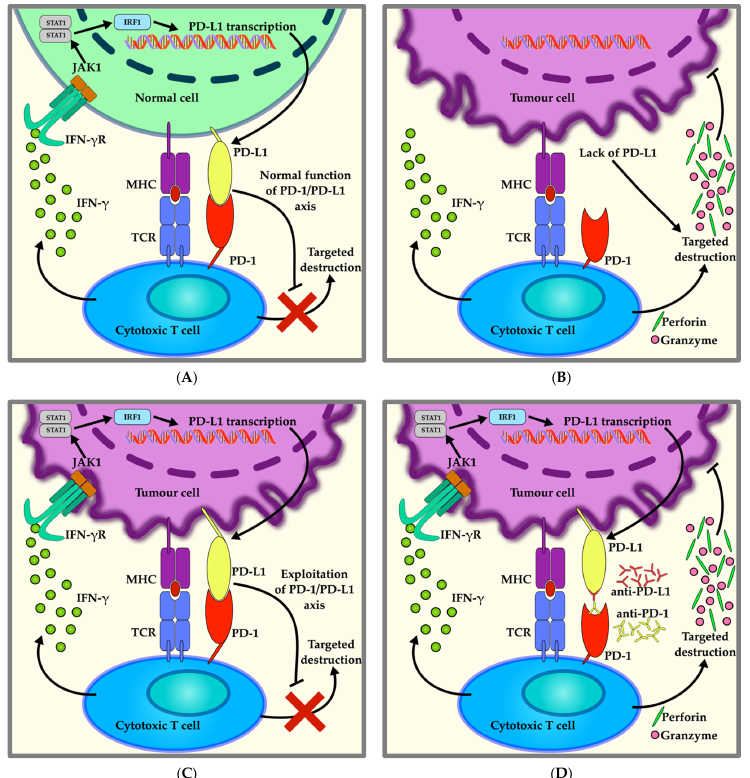
Figure 1. Immune targeting of cells by cytotoxic T cells: ( A ) Mechanism of immune tolerance of a native cell by the activa- tion of the PD-1/PD-L1 axis. A T cell is activated by an antigen presented on a major histocompatibility complex (MHC) molecule on the surface of the cell. This triggers the release of inflammatory cytokines, such as interferon gamma (IFN- γ ), that bind its receptor (IFN- γ R) on the cell membrane, upregulating the expression of PD-L1 . The interaction between PD- L1 and PD-1 on the T-cell surface works as a mechanism of cell recognition and promotes immune tolerance, preventing the destruction of the cell. ( B ) Mechanism of immune targeting of a tumour cell. Conversely, when the cytotoxic T cell recognizes the antigen presented on an MHC, but no PD-L1 is expressed, the release of IFN- γ and cytolytic mediators (perforin and granzymes) results in (tumour) cell elimination. ( C ) Mechanism of immune evasion of the tumour cell by exploiting PD-1/PD-L1 axis. The cytotoxic T-cell activation recognizes the tumour antigen presented on its MHC, but PD- L1 transcription is activated by IFN- γ . PD-L1 inhibits anti-tumour activity of the cytotoxic T cell. ( D ) Mechanism of PD- 1/PD-L1 blockade by anti-PD-1 or anti-PD-L1 immune checkpoint inhibitors (ICIs). The antibodies block the interaction between PD-1 and PD-L1, preventing inhibition of cytotoxic T-cell antitumor activity and triggering the release of perforin and granzymes for the elimination of the tumour cell and thereby surpassing the PD-1/PD-L1 blockade. 3. Immune Checkpoint Inhibitors and Immunotherapy In the later 20th century, blockage of the interaction between PD-L1 and PD-1 was proposed as a possible therapeutic path to combat tumour growth, and studies using monoclonal antibodies targeting immune checkpoints (such as PD-L1/PD-1) started to proliferate (Figure 1D). These antibodies are referred to as immune checkpoint inhibitors (ICIs). It was clear from the early studies with mice xenografts that treatment with ICIs produced recovery of effector T-cell functions and a decrease in tumour size [15,16]. In 2015, the Food and Drug Administration (FDA) approved the use of the first anti- PD-1 monoclonal antibody (Nivolumab) as second-line treatment of NSCLC after the re- sults of the clinical trials CheckMate 017 and CheckMate 057 showed an improved response over standard chemotherapy in NSCLC patients [17]. Moreover, CheckMate 017 showed an improved OS in NSCLC patients treated with Nivolumab compared to standard treat- ment with Docetaxel (median OS: 9.2 months vs. 6.0 months, respectively) [18]. In 2016, the FDA also approved the use of Pembrolizumab (anti-PD-1) as first- or second-line mon- otherapy treatment in NSCLC patients and Atezolizumab (anti-PD-L1) for patients with disease progression during or following platinum-based chemotherapy [19–22]. Multiple ICIs have since been developed and approved by the FDA and other government agencies (Table 1).